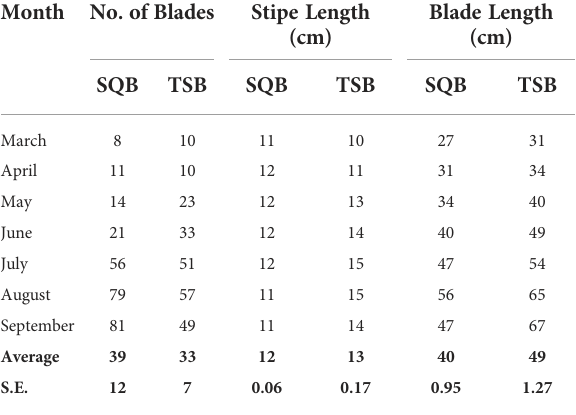
TABLE 1 Number of blades, stipe length (cm), and blade length (cm) during the growing phase (March to September) of Eisenia arborea cultured from Todos Santos Bay and San Quint ı ́ n Bay.